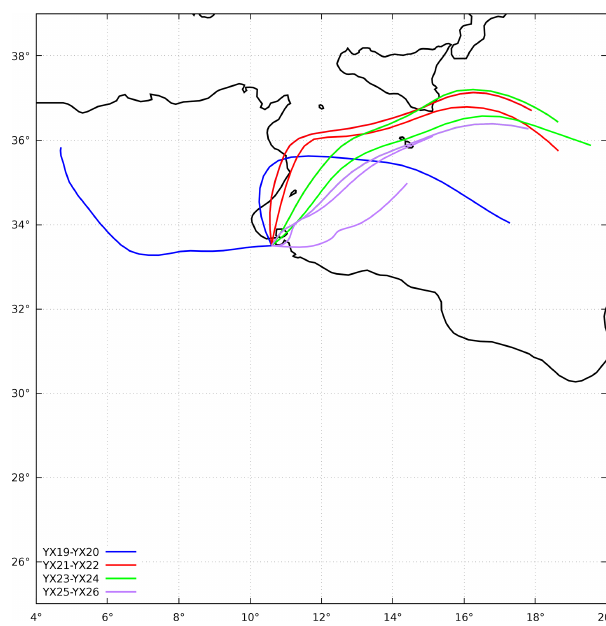
Figure C4. Backward trajectories of sample pairs YX19–YX20, YX21–YX22, YX23–YX24, and YX25–YX26. The x axis is lon- gitude, and the y axis is latitude. Two or three trajectories are asso- ciated with a given sample pair of ≈ 12h duration.